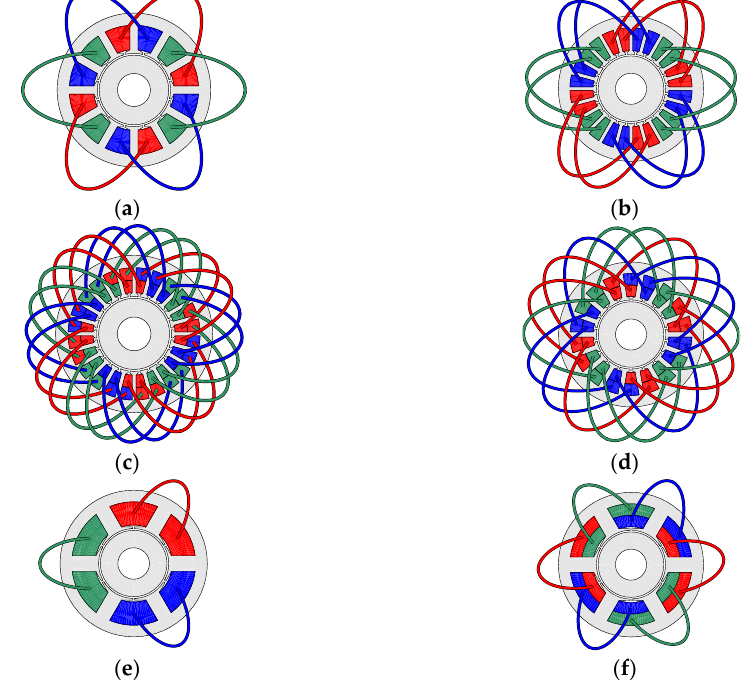
Figure 1. Different examples of four pole machine winding configurations ( a ) integral-slot distributed-winding (ISDW) ( p = 2, Q s = 12, n l,w,s = 1); ( b ) ISDW ( p = 2, Q s = 24, n l,w,s = 1); ( c ) ISDW ( p = 2, Q s = 24, n l,w,s = 2, τ a = 1); ( d ) fractional-slot distributed-winding FSDW ( p = 2, Q s = 18, n l,w,s = 2); ( e ) fractional-slot concentrated-winding FSCW ( p = 2, Q s = 6, n l,w,s = 1); ( f ) FSCW ( p = 2, Q s = 6, n l,w,s =